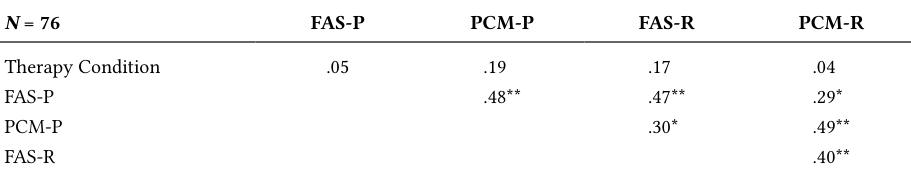
Bivariate Listwise Pearson Correlations Between Predictors, FAS, and PCM Measures N = 76 FAS-P PCM-P FAS-R PCM-R Therapy Condition .05 .19 .17 .04 FAS-P .48** .47** .29* PCM-P .30* .49** FAS-R .40** Note . FAS-P = Family Attitude Scale rated by patients; FAS-R = Family Attitude Scale rated by